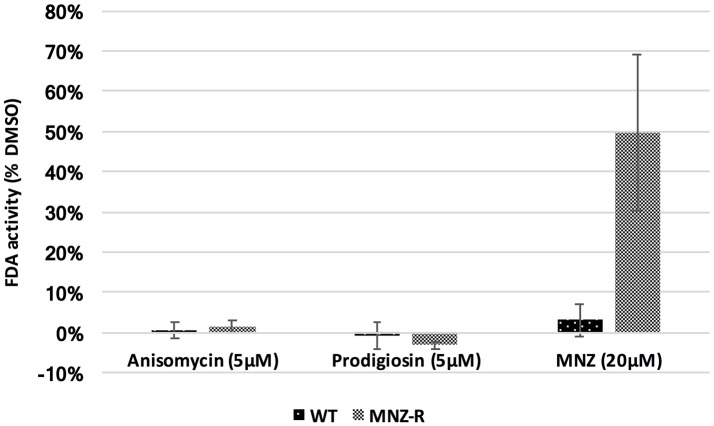
Activity against MNZ resistant E. histolytica parasites. E. histolytica trophozoites resistant to MNZ at concentrations up to 15 μM, as well as wild-type MNZ sensitive parasites, were exposed to 5 μM of anisomycin or prodigiosin, and assayed for survival after 72 h by FDA fluorescence. Both drugs were equally potent against MNZ resistant parasites (MNZ-R) as against wild type parasites. Fluorescence readings for DMSO, anisomycin and prodigiosin treated parasites is shown. Survival of both strain in 20 μM MNZ is also included. Error bars are ± standard error.